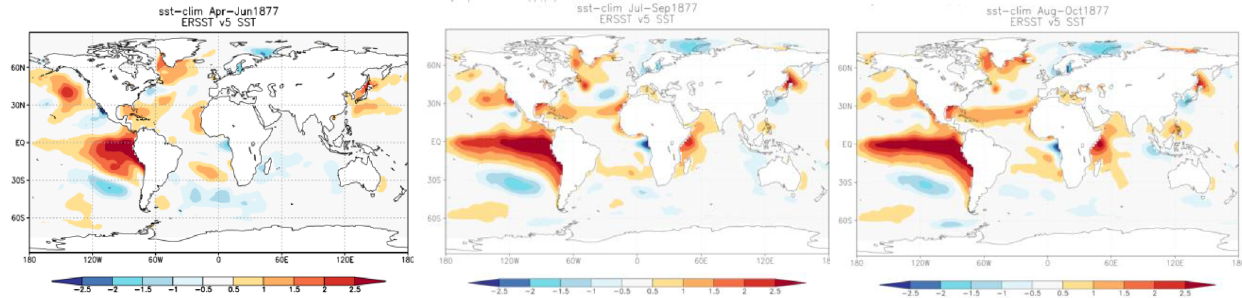
Figure 4. Reconstructions of sea surface temperature (SST) from April to October 1877 generated from the climate data from ERSSTv5 (SST anomalies with respect to the period 1854–2020) available on the WMO Climate Explorer, European Climate Assessment & Dataset (KMNI) (https://climexp.knmi.nl/start.cgi, last access: 12 December 2020) using in-built correlation software, courtesy of Rob Allan, UK Met Office (UKMO), and lead of the global ACRE initiative.